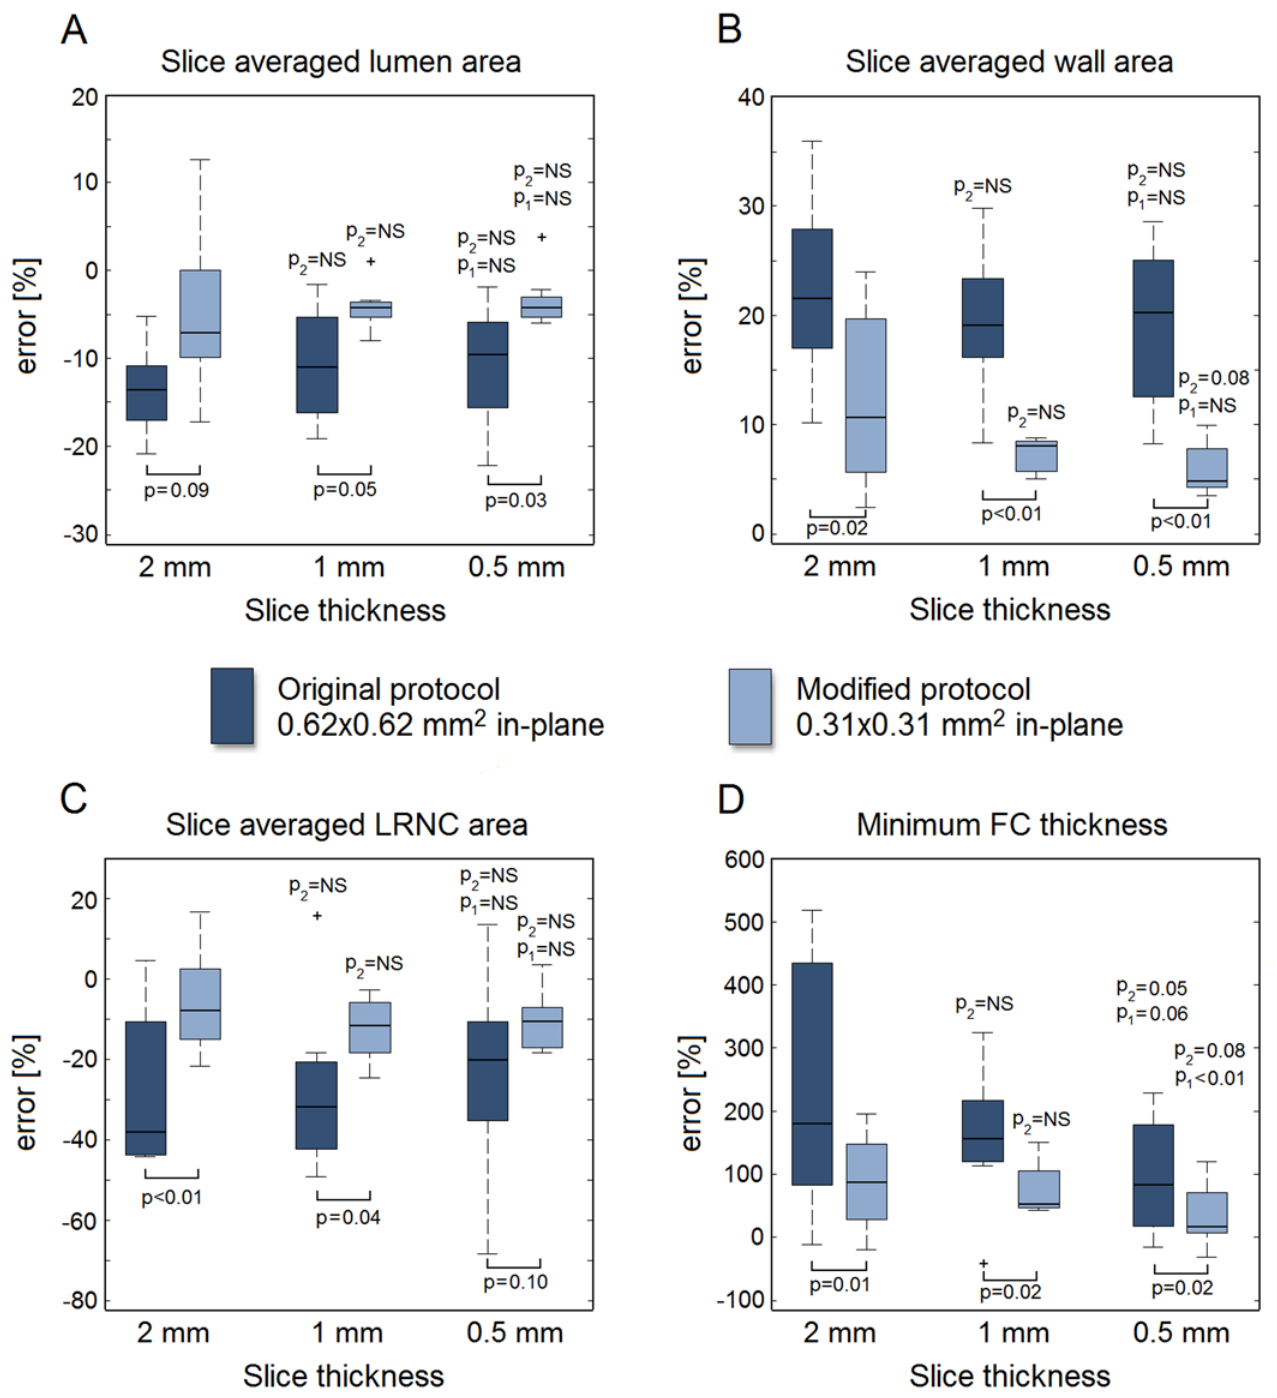
Fig 5. Relative error in measured value with respect to the ground truth for the geometrical parameters studied: (A) lumen area, (B) wall area, (C) LRNC area, and (D) minimum FC thickness. Whiskers in the box plots represent maximum/minimum data points not considering outliers, which are marked by plus (+) symbols. The p-values with respect to the 2-mm and 1-mm slice data are indicated with p2 and p1, respectively. A p-value is denoted as NS (not significant) if p > 0.10.